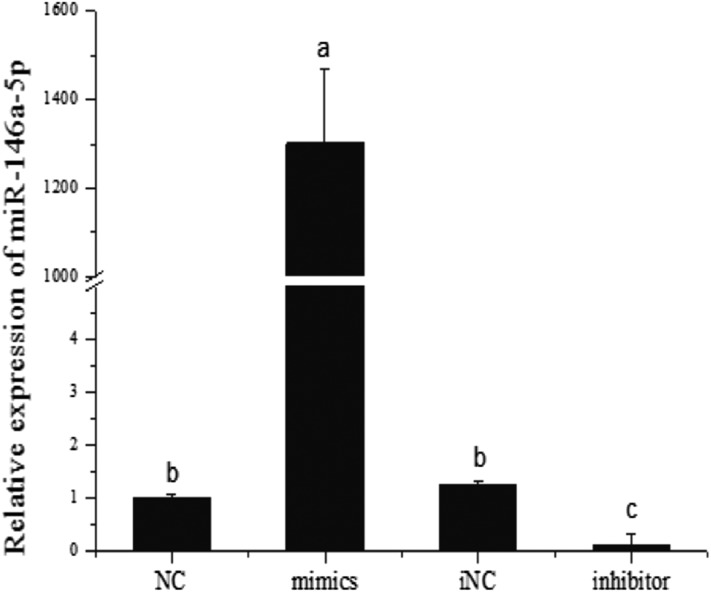
The endogenous miR-146a-5p levels with transfection of miRNA mimics or inhibitor. miR-146a-5p mimics/NC/inhibitor/iNC were transfected into preadipocytes, and cells were collected on day 8 postinduction. After transfection and day 8 postinduction with miR-146a-5p mimics and inhibitor, the expression levels of miR-146a-5p were measured by a qPCR-based method. miRNA mimics and inhibitor significantly increased and decreased miR-146a-5p levels compare with NC and iNC control, respectively, in adipocytes. The means in each column followed by the different letters represent significant difference (P < 0.05), and the same letter represents nonsignificant difference (P > 0.05, n = 8).